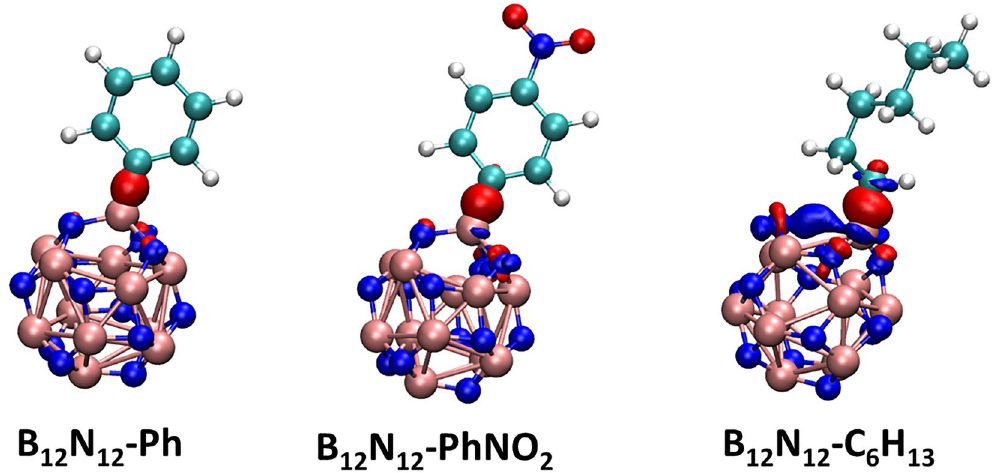
Figure 9. EDD for the grafted B 12 N 12